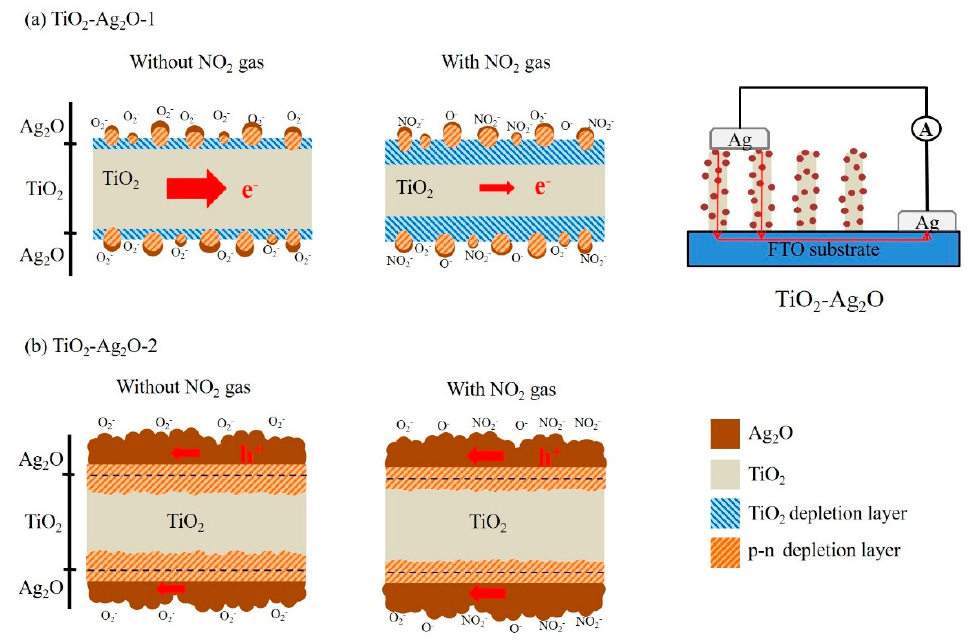
Figure 9. Schematic illustrations for possible gas-sensing mechanisms of ( a ) TiO 2 –Ag 2 O-1 and ( b ) TiO 2 –Ag 2 O-2 toward NO 2 gas.